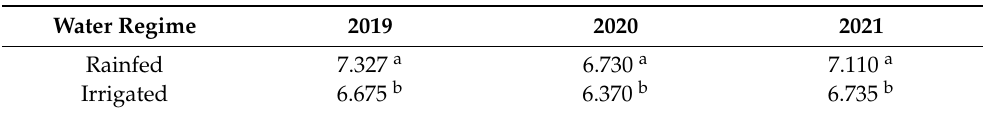
Means that do not share a letter within a column are significantly different, p =